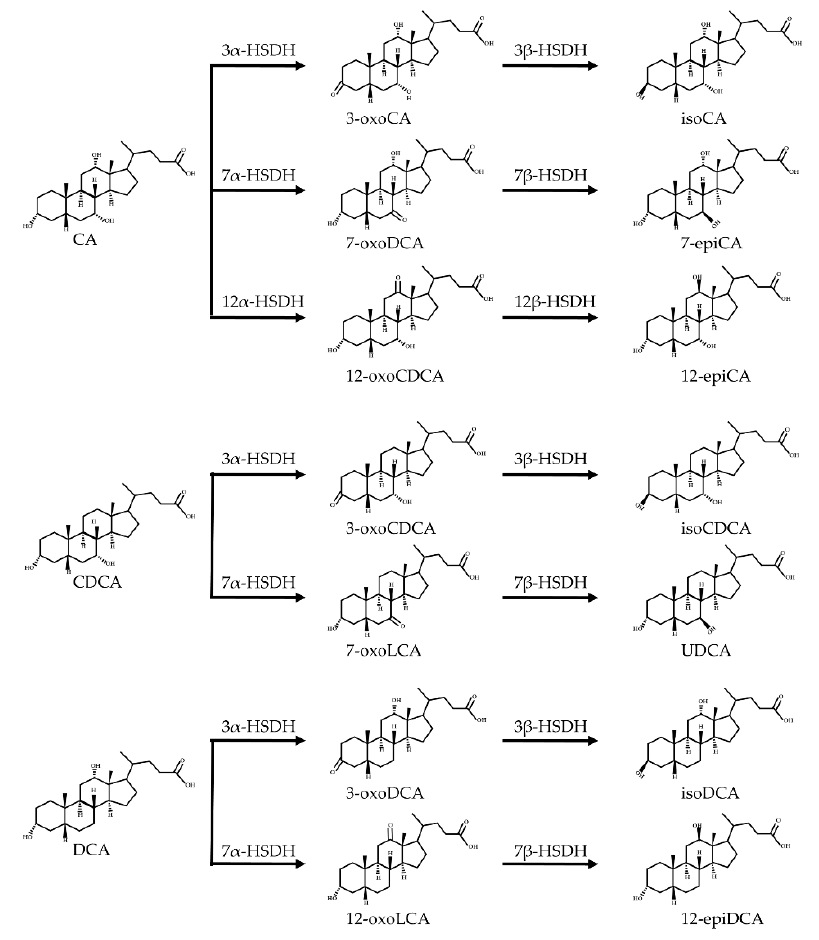
Figure 4. Oxidative and isomerization pathways of bile acids: Under the action of the α / β -hydroxy steroid dehydrogenase (HSDH) enzyme of the intestinal bacteria, primary bile acids produce oxy- genated bile acid intermediates, which change the stereospecificity of bile acids, reduce their toxicity, and enrich the bile acid types.